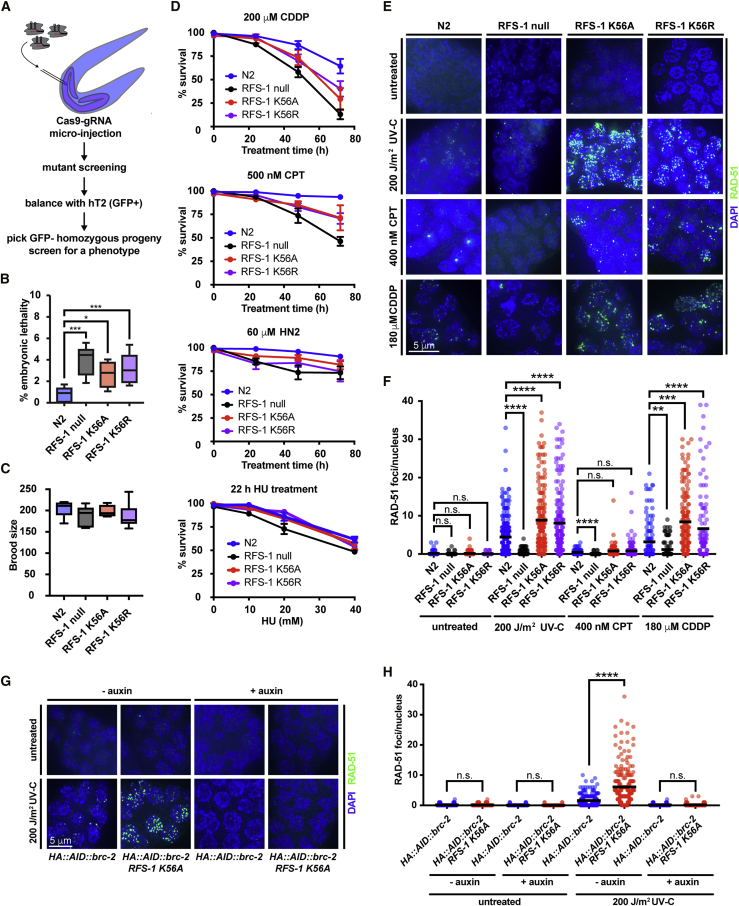
RFS-1 K56A/R C. elegans strains accumulate HR-incompetent RAD-51 foci after DNA damage(A) A schematic for CRISPR-Cas9 knockin strategy for generation of RFS-1 Walker box mutant strains.(B) Embryonic lethality analysis of rfs-1 mutants in vivo. Percentage of unhatched eggs was scored after 24 h in strains of the indicated genotype. Progeny of 6–8 worms were evaluated.(C) Brood size of strains of the indicated genotype. Progeny of 5–8 worms was evaluated.(D) The indicated strains were treated with indicated doses of genotoxins for the indicated time. rfs-1 null, rfs-1 K56A and rfs-1 K56R strains display increased sensitivity to replication-associated DSBs lesions caused by CDDP, CPT, and HN2 mustards, whereas sensitivity to replication fork stalling in the presence of hydroxyurea is mild in rfs-1-null strain and absent in RFS-1 K56A and RFS-1 K56R strains. Error bars represent SEM.(E) Representative images of the mitotic compartment of C. elegans germline after treatment with different genotoxins. DAPI staining (blue), RAD–51 staining (green). Scale bar represents 5 μm.(F) Quantification of RAD-51 focus formation in the mitotic zone of the worm germline under different treatments in strains of the indicated genotype. Between 99 and 261 cells were quantified for each condition in 2–3 representative germlines for each genotype. Mann-Whitney test was used for statistical analysis.(G) Representative images of the mitotic compartment of C. elegans germline of indicated genotypes after treatment with indicated dose of UVC grown in the presence or absence of auxin. HA::AID::brc-2 corresponds to C. elegans strain modified to express BRC-2 N-terminally fused to HA followed by auxin-inducible degron. DAPI staining (blue), RAD–51 staining (green). Scale bar represents 5 μm.(H) Quantification of RAD-51 focus formation in the mitotic zone of the worm germline under different treatments in strains of the indicated genotype. Between 99 and 261 cells were quantified for each condition in three representative germlines for each genotype.